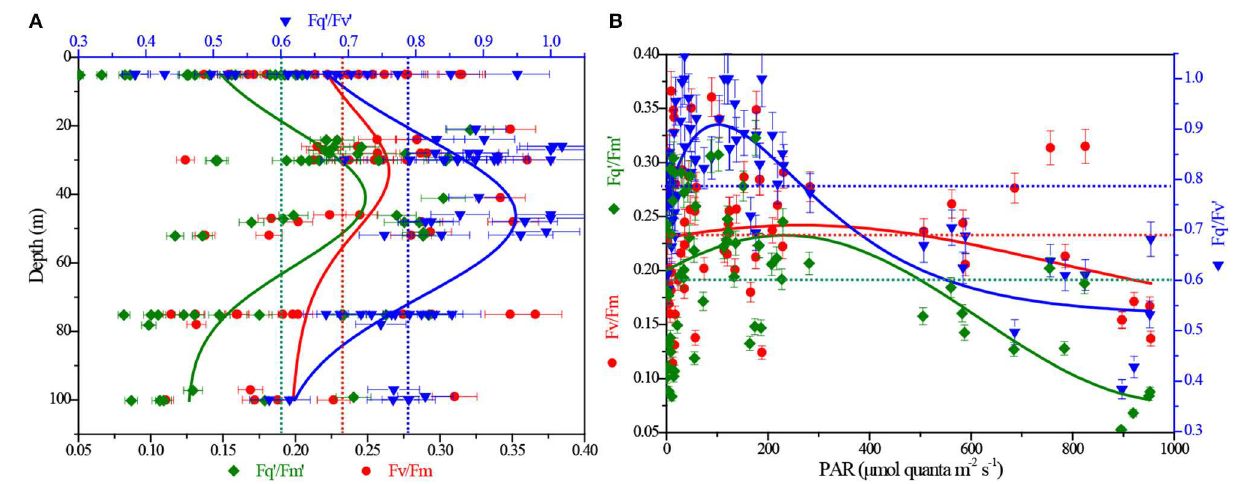
FIGURE 4 | Depth and light dependency of ChlF-derived F v /F m , F ′ q /F ′ m and F ′ q /F ′ v from FRRF measurements. (A) F v /F m , F ′ q /F ′ m and F ′ q /F ′ v vs. depth; (B) F v /F m , F ′ q /F ′ m and F ′ q /F ′ v vs. light. The red, olive and blue dashed lines represent the averaging of F v /F m , F ′ q /F ′ m and F ′ q /F ′ v , respectively.